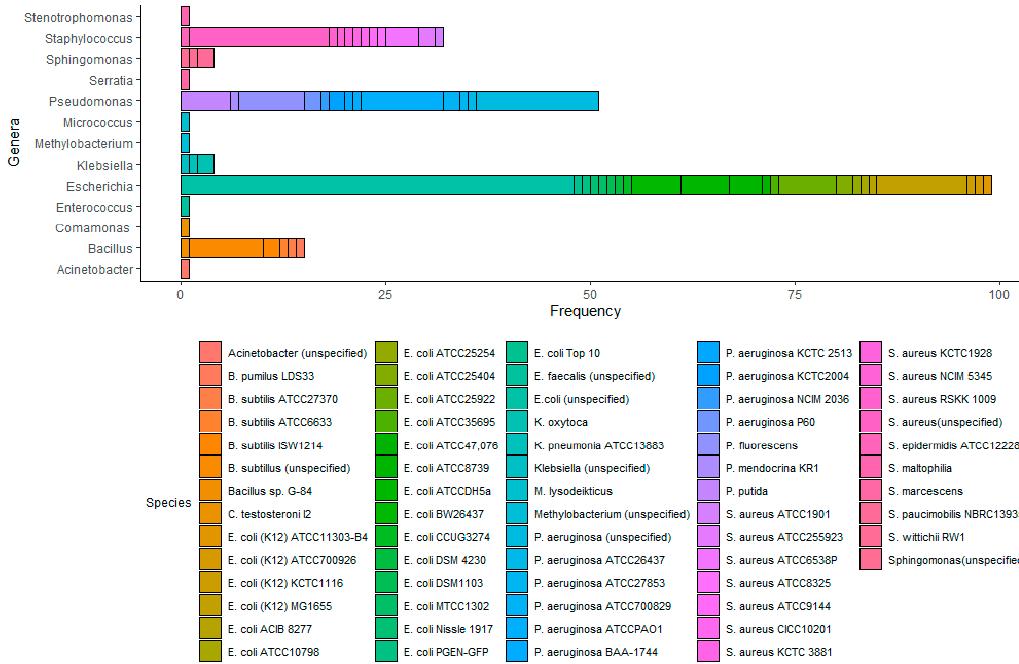
Figure 3. Frequency, in terms of the number of articles where the organism occurs, of use of microorganisms to study antimicrobial efficacy against biofilms on RO membranes cited in the literature. Data were acquired from an analysis of 135 articles related to biofouling in water treatment systems.